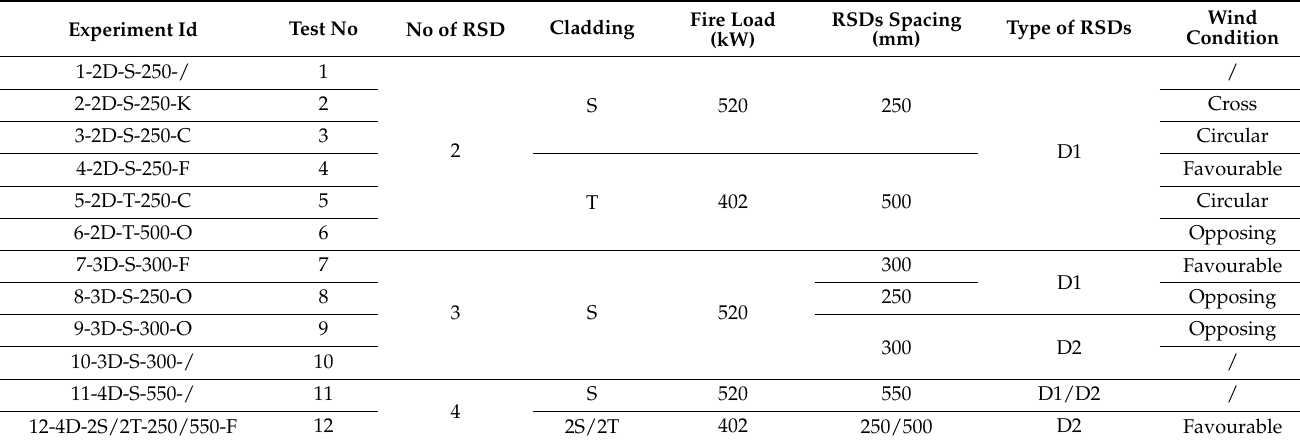
Table 2. Summary of testing